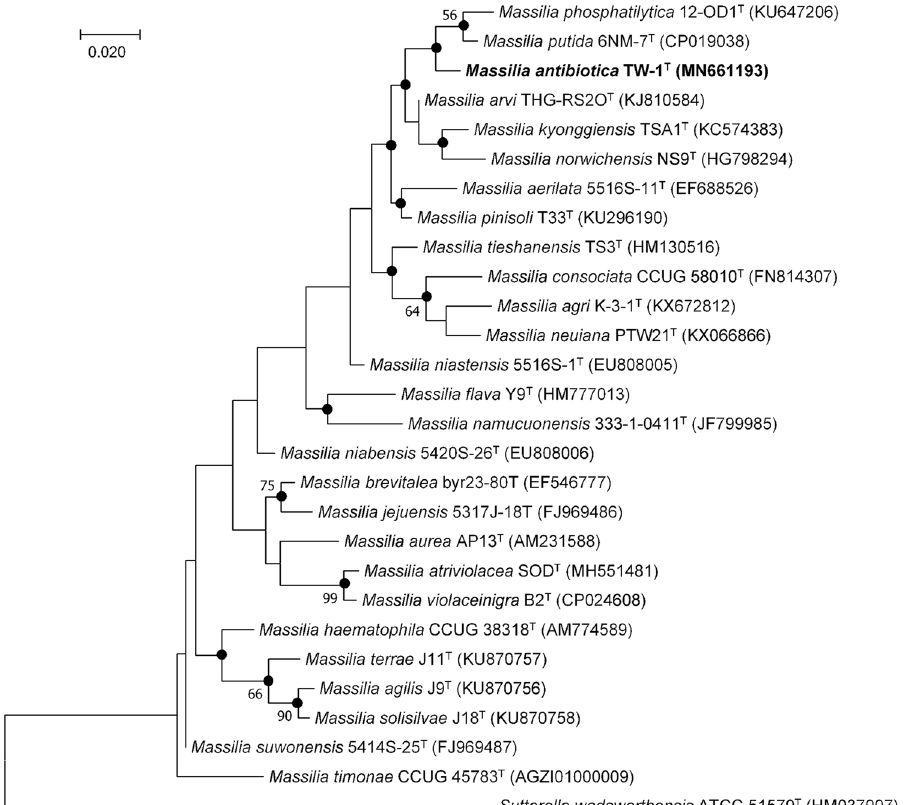
Figure 1. Maximum-likelihood phylogenetic tree based on 16S rRNA gene sequences showing the position of strain TW-1 T among the closest members of the genus Massilia . Filled circles are recovered by neighbour– joining and maximum–likelihood treeing methods. Bootstrap values (> 50%) based on 1000 bootstrap replicates are shown at branch nodes. Sutterella wadsworthensis ATCC 51579 T was used as an out-group. Numbers in parentheses indicate GenBank accessions. Bar, 0.020 substitutions per nucleotide